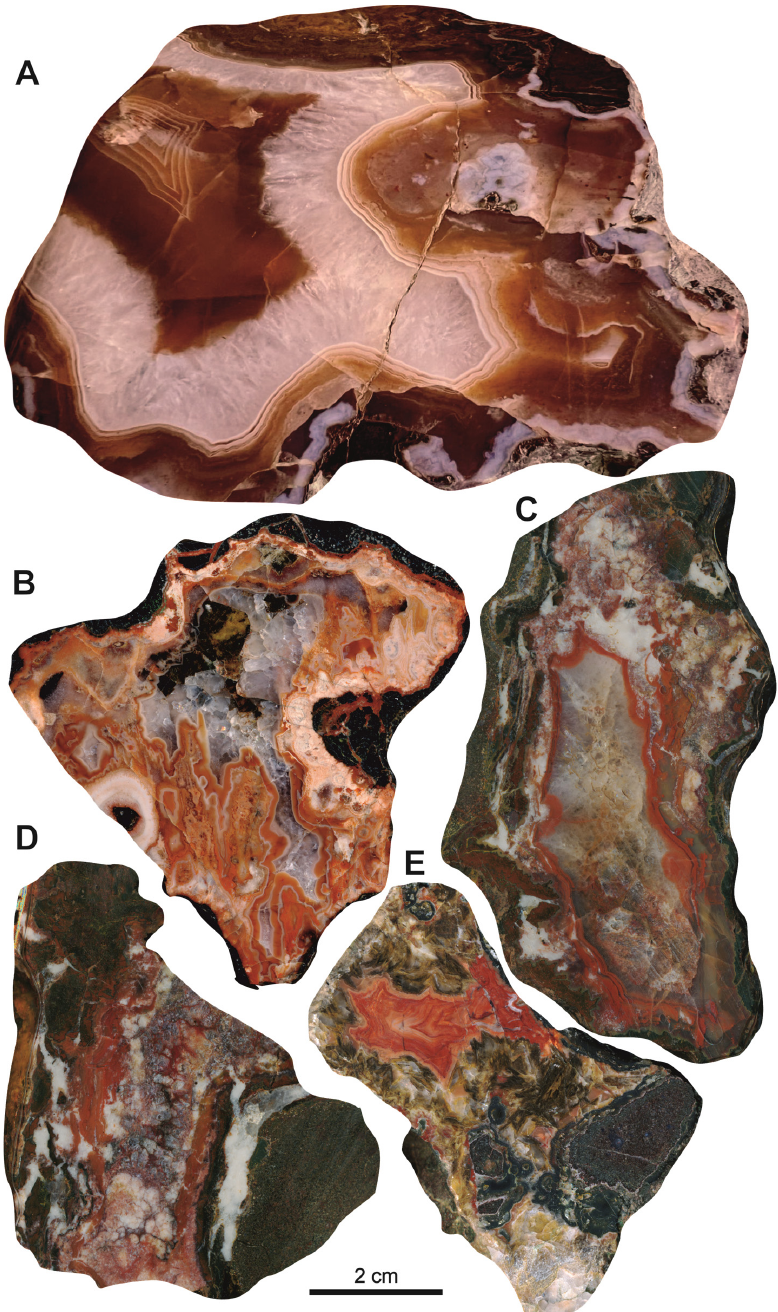
Figure 5. Photographs of agates from the Mesoproterozoic volcanics within the Pasha–Ladoga Basin (Priozersk Formation). ( A ) Monocentric agate nodule with well-developed concentric zoning and Fe-oxide pigment disseminated along individual chalcedony layers (museum expositional sample of the IG KRC RAS); ( B ) poor-fancy agate with red-brownish coloured chalcedony and calcite layers, as well as colourless quartz-rich portion; ( C ) concentrically zoned agate with red-brownish pigment distributed along the external margin of the amygdale; ( D ) fragment of the vein agate with red-brownish pigment irregularly distributed within chalcedony; ( E ) concentrically zoned agate surrounded by silica–chlorite matrix.